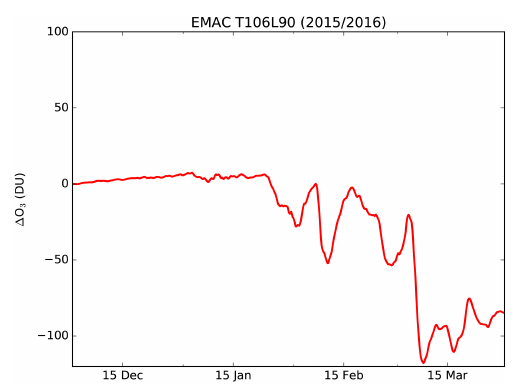
Figure 8. Total column ozone loss ( (cid:49) O 3 ) from EMAC T106L90 (70–90 ◦ N) for the 2015/2016 Arctic winter. Total column loss has ( (cid:49) O 3 = O 3 − O ∗ ), av- 3 3 been derived from the difference between the active tracer O 3 and the passive tracer O ∗ ( (cid:49) O 3 = O 3 − O ∗ 3 3